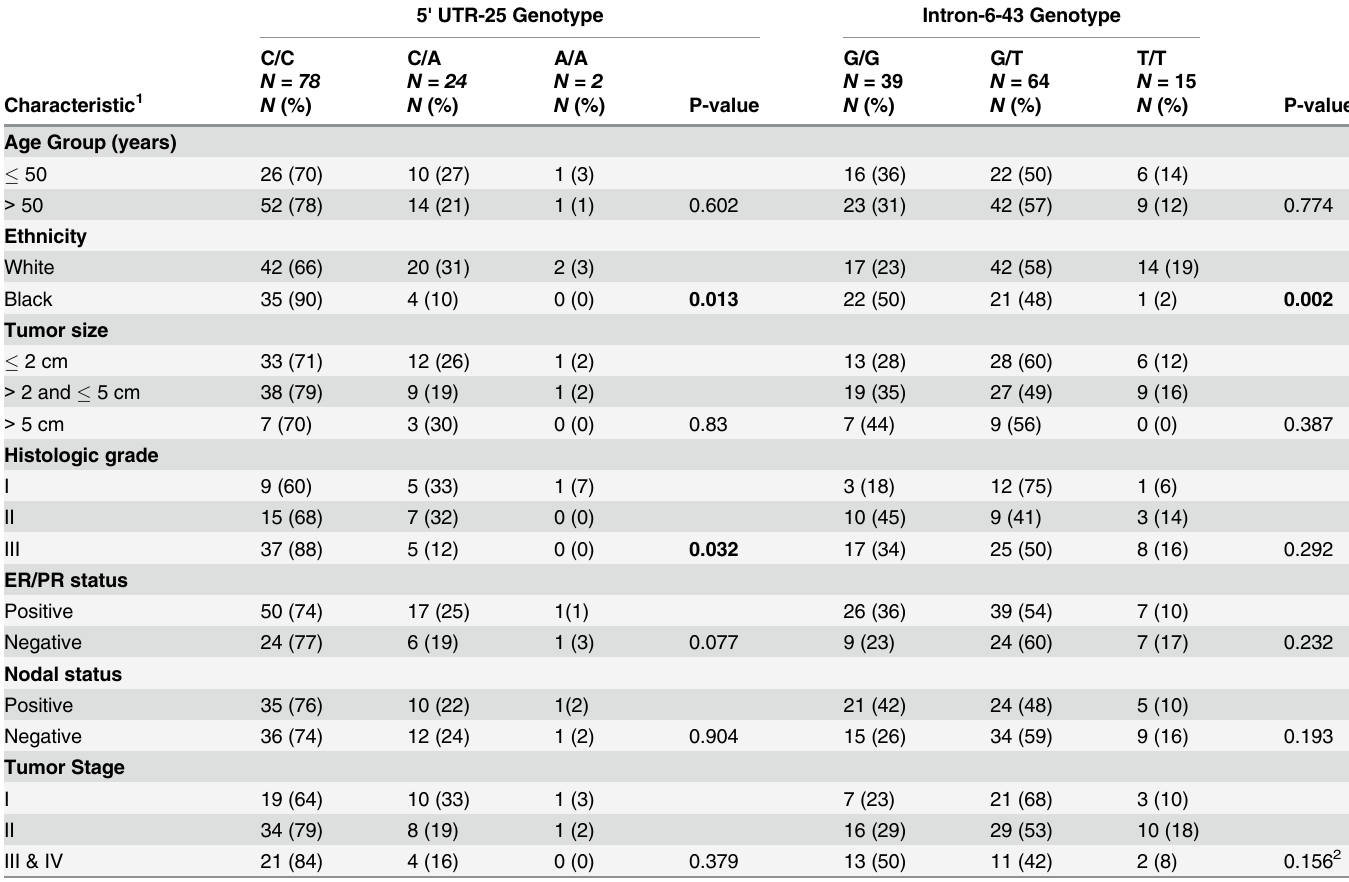
Table 3. Relationship between clinicopathological features and SNPs at 5 ’ UTR-25 and intron-6-43 of RPH3AL in breast cancers. 5' UTR-25